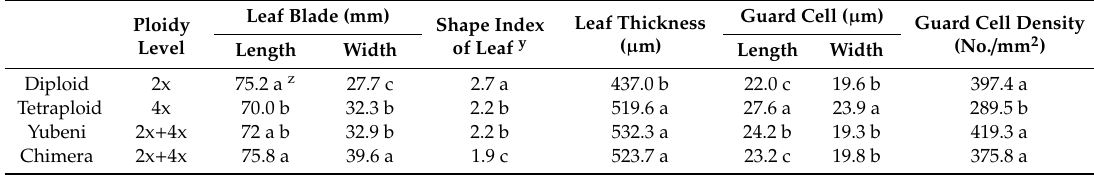
y Length of leaf blade / width of leaf blade; z di ff erent letters represent significant di ff erences in Tukey’s multiple test, 1%